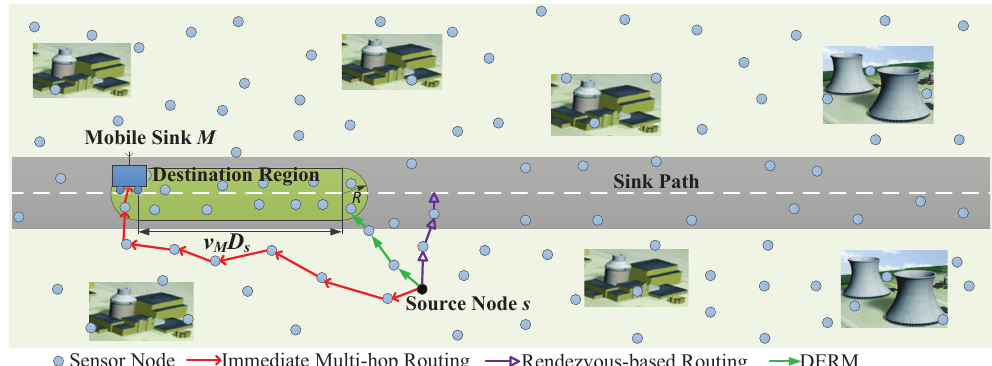
Figure 1. Three routing schemes in wireless sensor networks with a path-fixed mobile